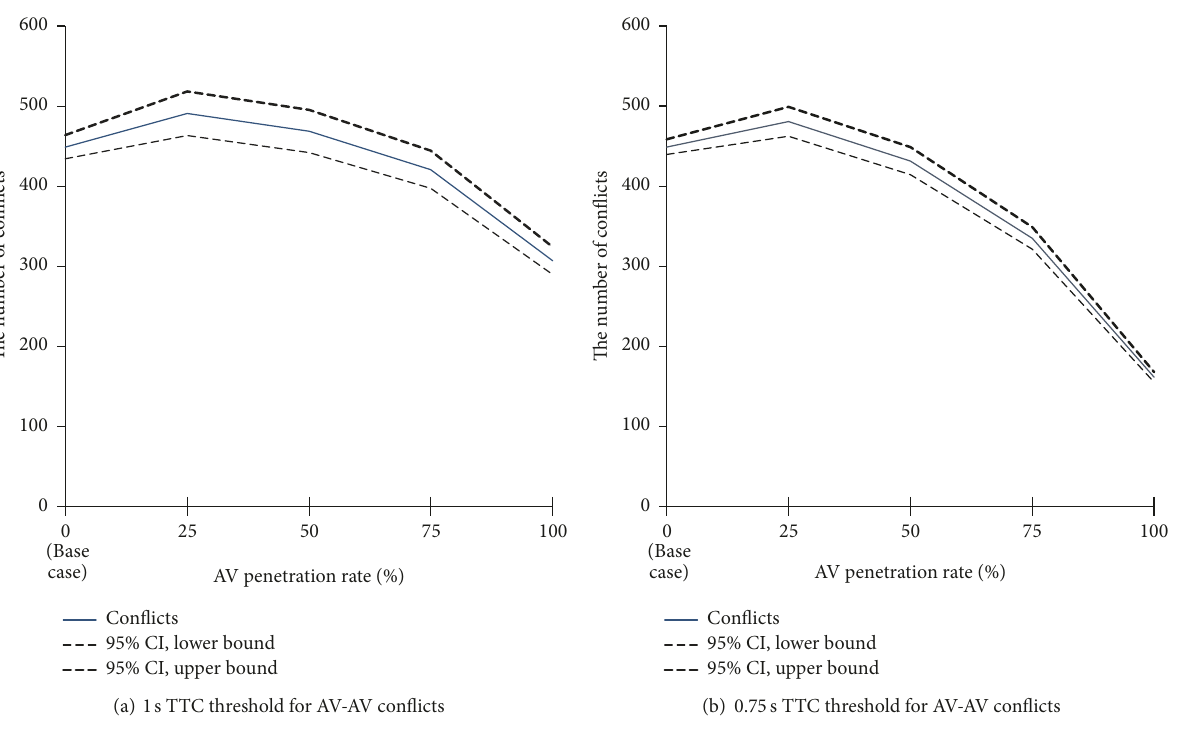
Figure 10: Total number of conflicts by AV penetration rate for the roundabout (AV-2 parameters).